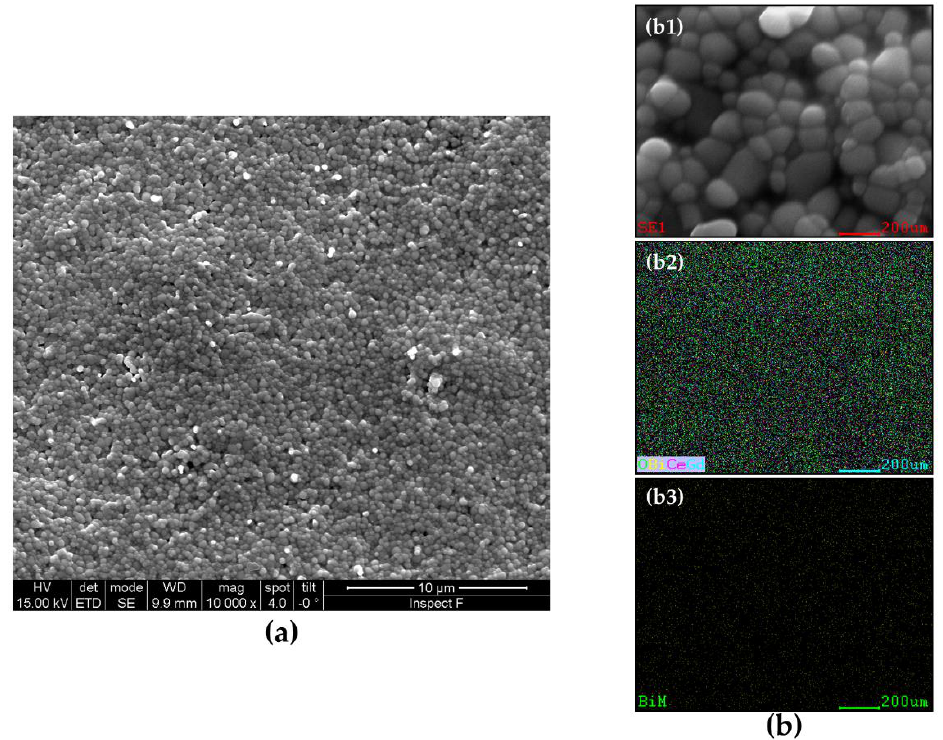
Figure 7. ( a ) SEM micrograph and ( b ) Elements mapping by EDS of sample 2Bi sintered at 1250 °C for 3 h after exposure for 100 h at 700 °C.